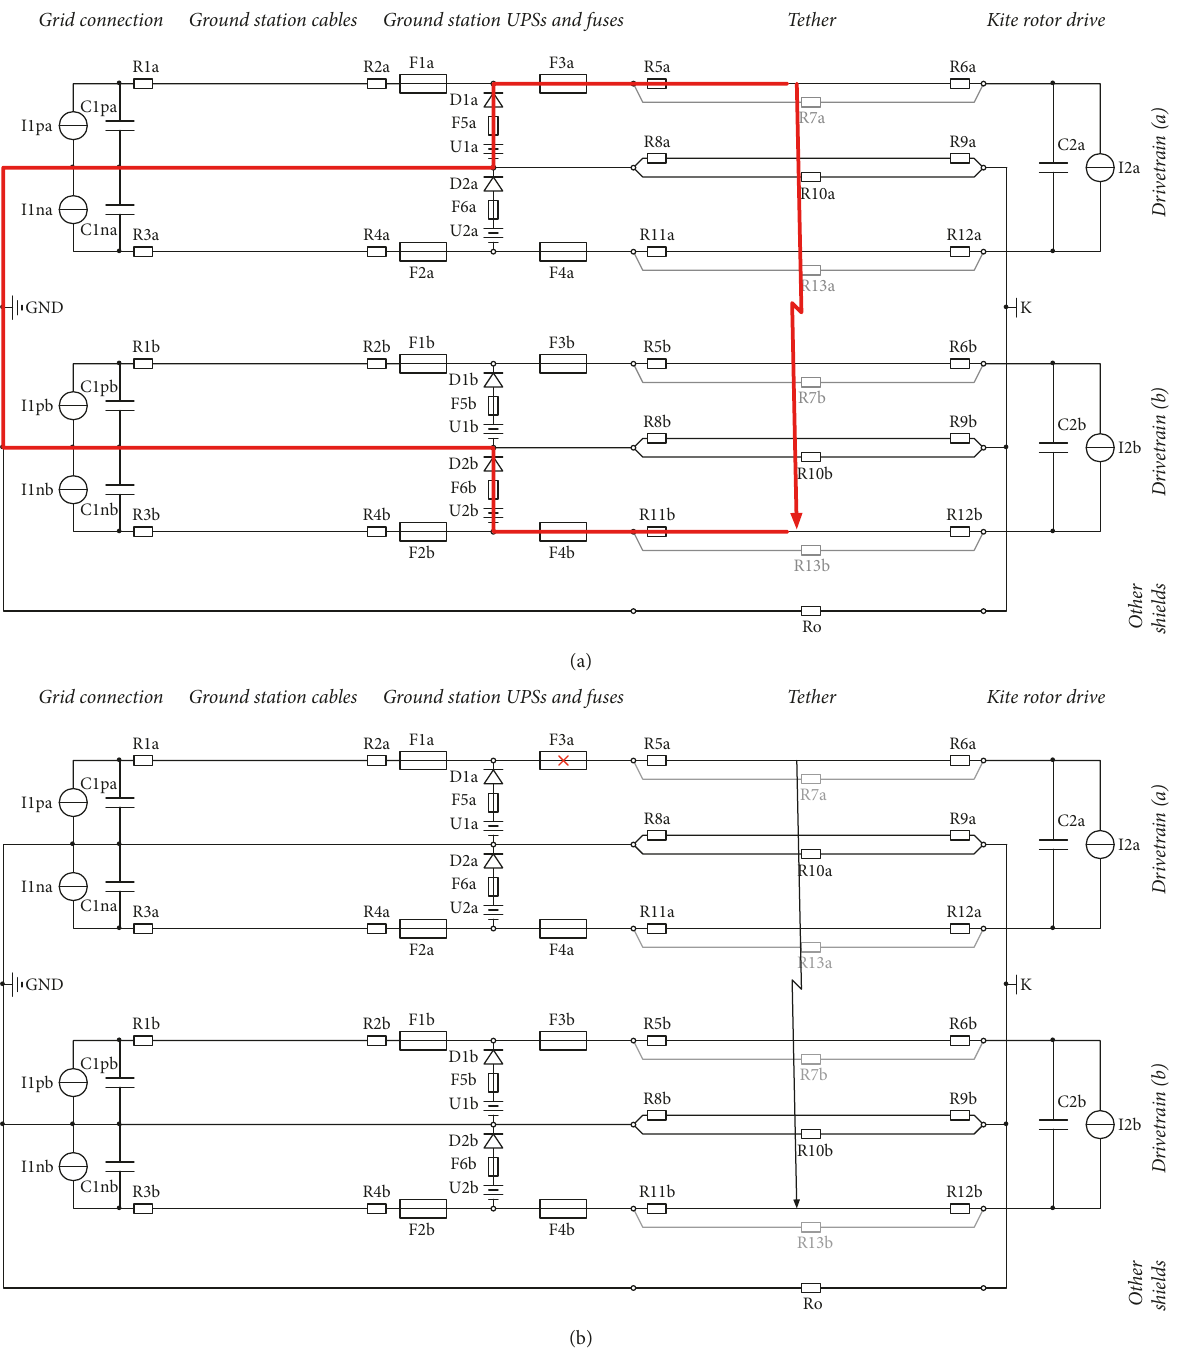
Figure 20: Investigation of short circuit fault S7: (a) short circuit currents driven by UPS(s) and (b) circuit after fuse opened.